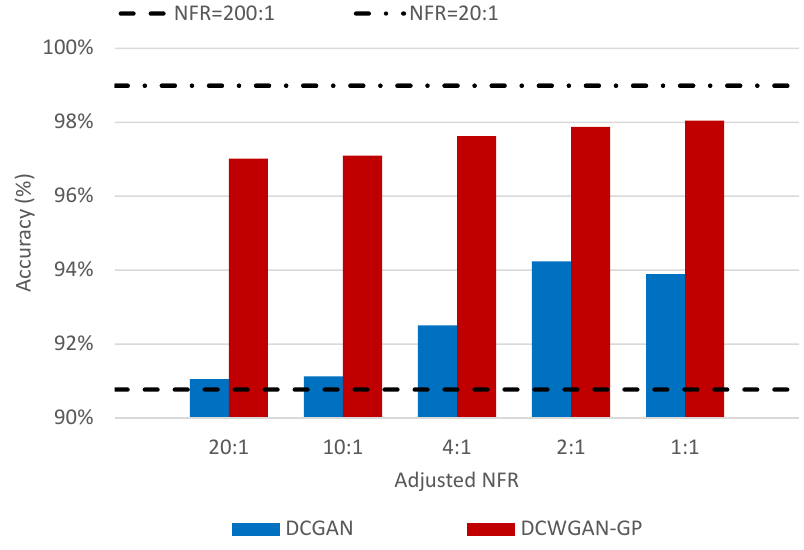
Figure 14. Fault detection and diagnosis (FDD) accuracy testing:normal-to-fault-ratio (NFR) = 200:1 with 10,000 normal data.